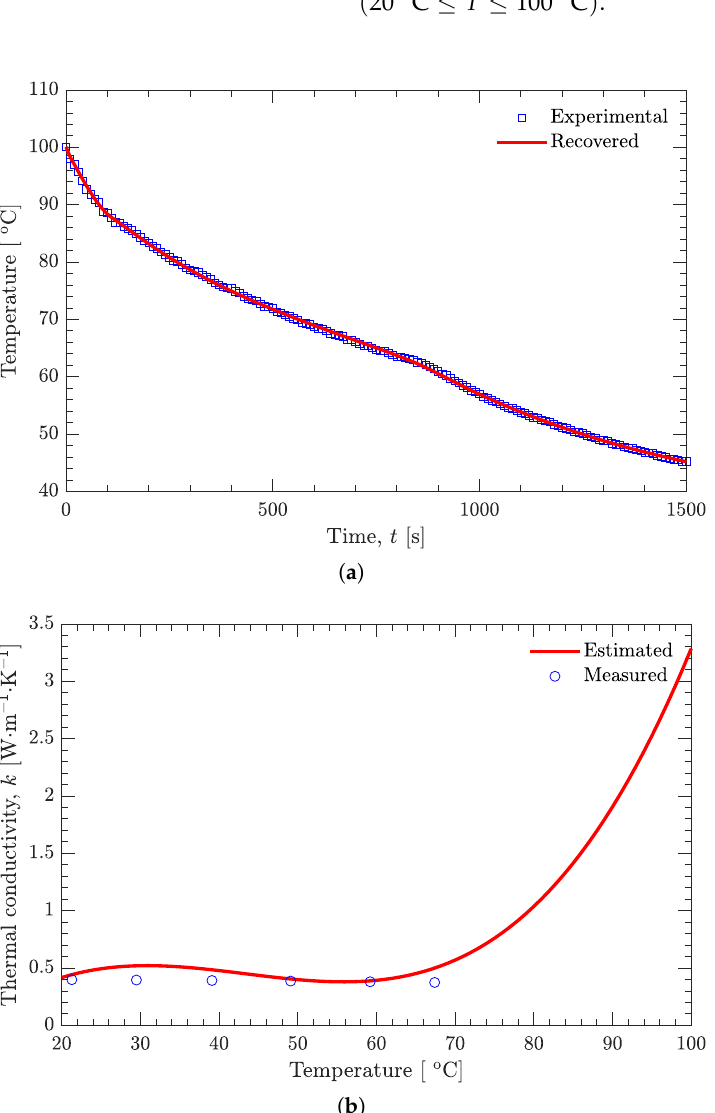
Figure 8. Recovered temperature and estimated thermal conductivity based on the experimentally measured temperatures of the DNAN/HMX melt-cast explosive. ( a ) Temperature. ( b ) Thermal con-